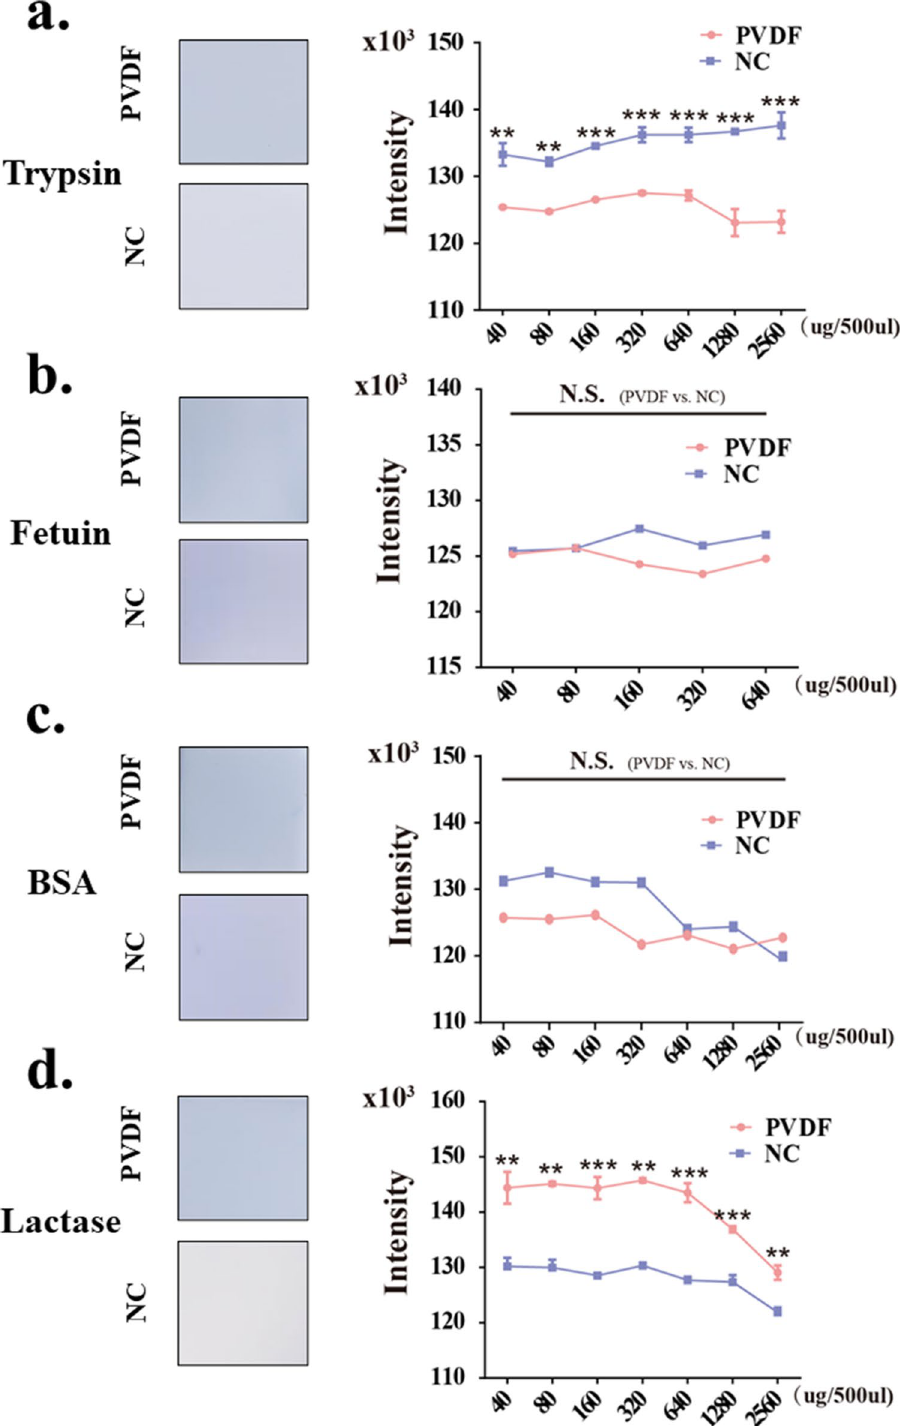
Figure 6. Comparison of the binding ability of PVDF membrane and NC membrane to trypsin, fetuin, BSA, lactase. PVDF and NC membranes (0.5 cm × 0.5 cm) were incubated with different concentrations (40, 80, 160, 320, 640, 1280, 2560 ug/500 uL) of proteins, such as ( a ) trypsin, ( b ) fetuin, ( c ) BSA, and lactase ( d ) for 2 h, followed with DB-71 staining. The left side of a, b, c, and d: representative blots; The right side of ( a – d ) the relative signal intensity of the proteins that binded on the two membranes were detected by staining with DB-71. Image J and GraphPad Prism Version 6 were used for density analysis and statistics. Pink line, PVDF membrane; Blue line, NC membrane. *Significantly different p < 0.05, ** p < 0.01, *** p < 0.001. N.S., not significant. All values are means ± S.E. (error